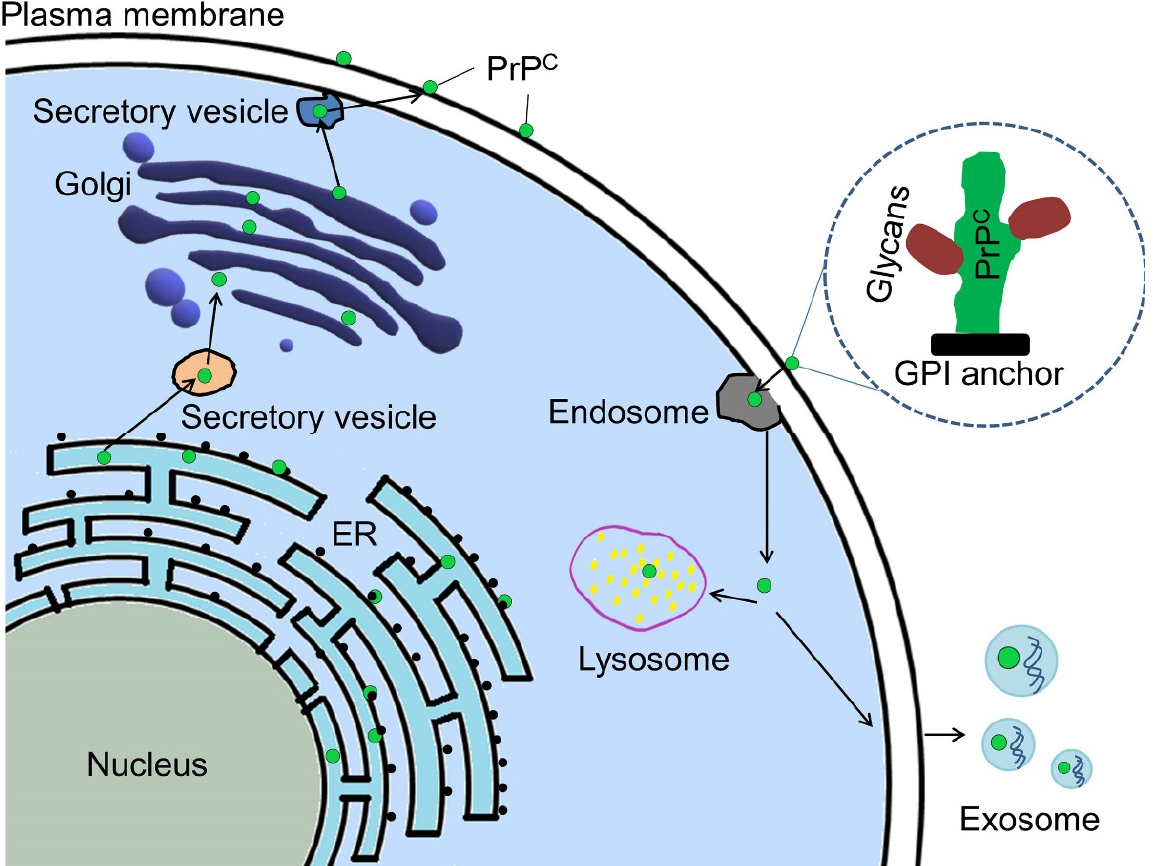
Figure 4. Mechanistic insight and trafficking routes of PrP C within a cellular environment. Green dots are representative form of PrP C . See Ref. [43] for a detailed description. Reprinted from Ref. [43] with permission under the terms of the Creative Commons Attribution License (CC BY).